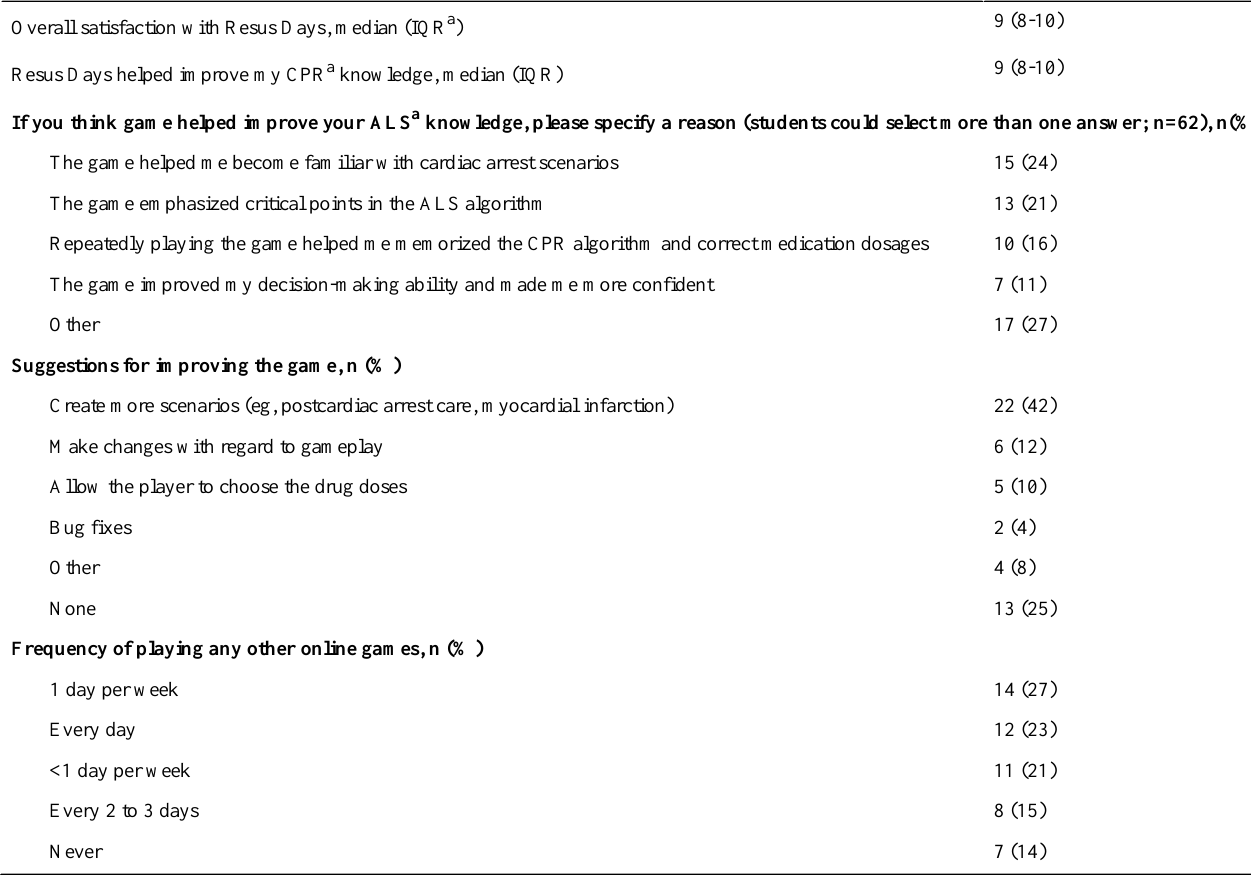
Participant in game group (n=52)Attitudes and